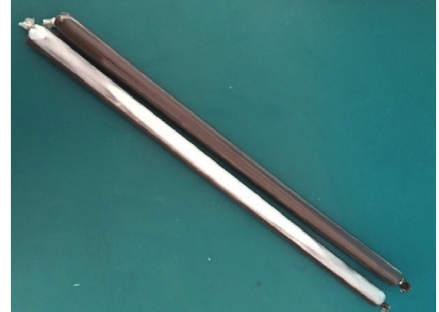
Figure 1: Resin anchor agent.